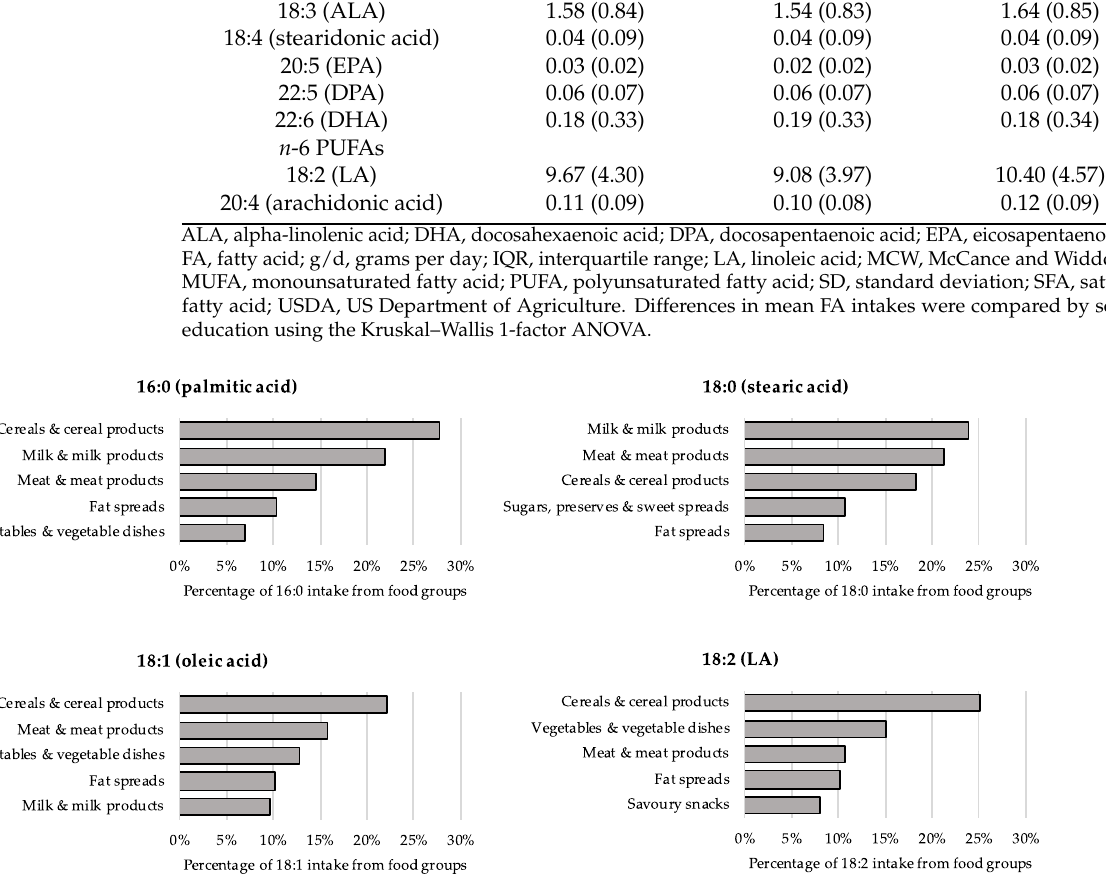
Figure 1. Top five food contributors to major individual FAs in the individual FA dataset (MCW + USDA) in 207,997 UK Biobank participants. FA, fatty acid; g/d, grams per day; LA, linoleic acid; MCW, McCance and Widdowson; MUFA, monounsaturated fatty acid; PUFA, polyunsaturated fatty acid; SFA, saturated fatty acid; USDA, US Department of Agriculture. Major individual FAs were those with mean intakes ≥5 g/d.